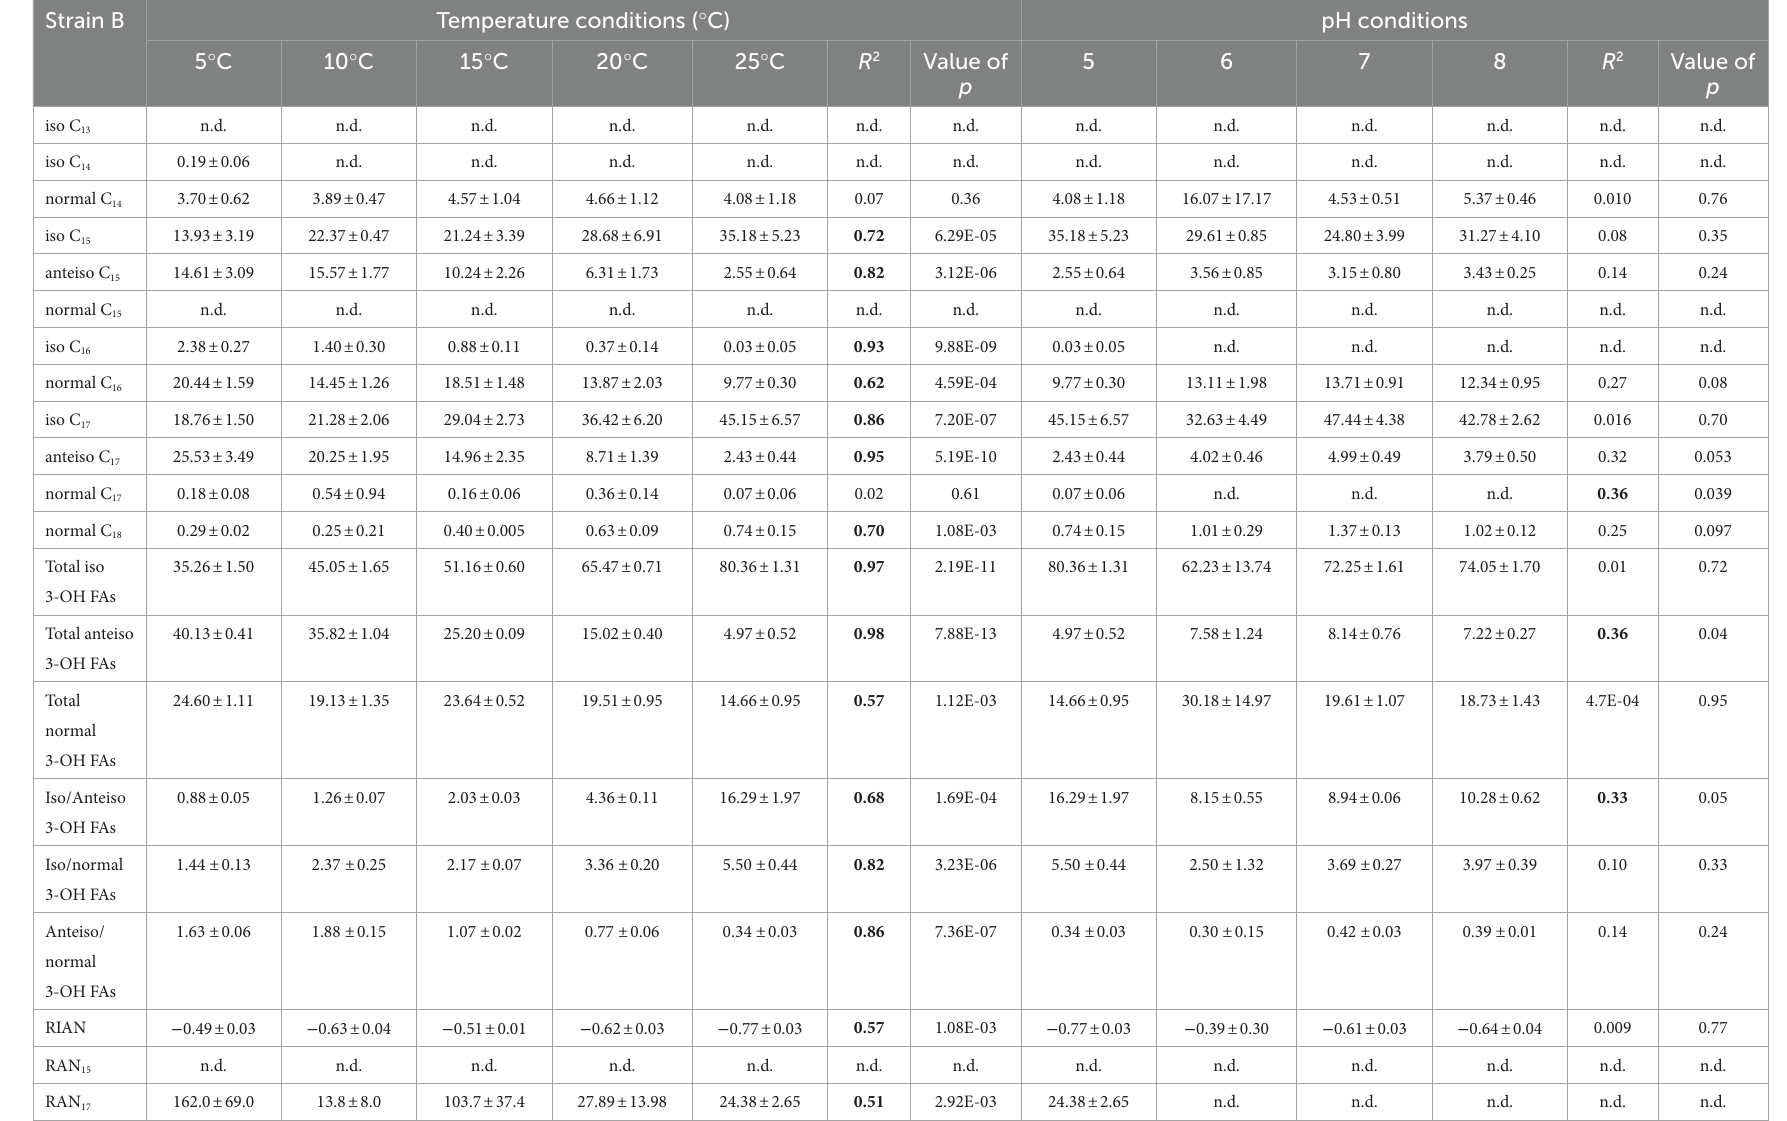
TABLE 5 Relative percentage abundances of 3-hydroxy fatty acids vs. total 3-hydroxy fatty acids and related indices [defined by Wang et al. (2016)] for strain B cultivated under different temperature (at pH 5) and pH (at 25 ° C)